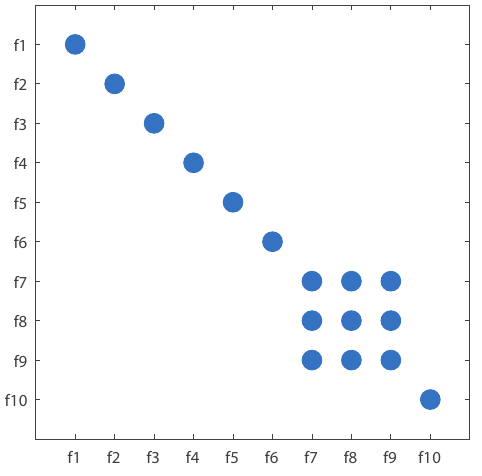
Figure 9. Detectability and isolability